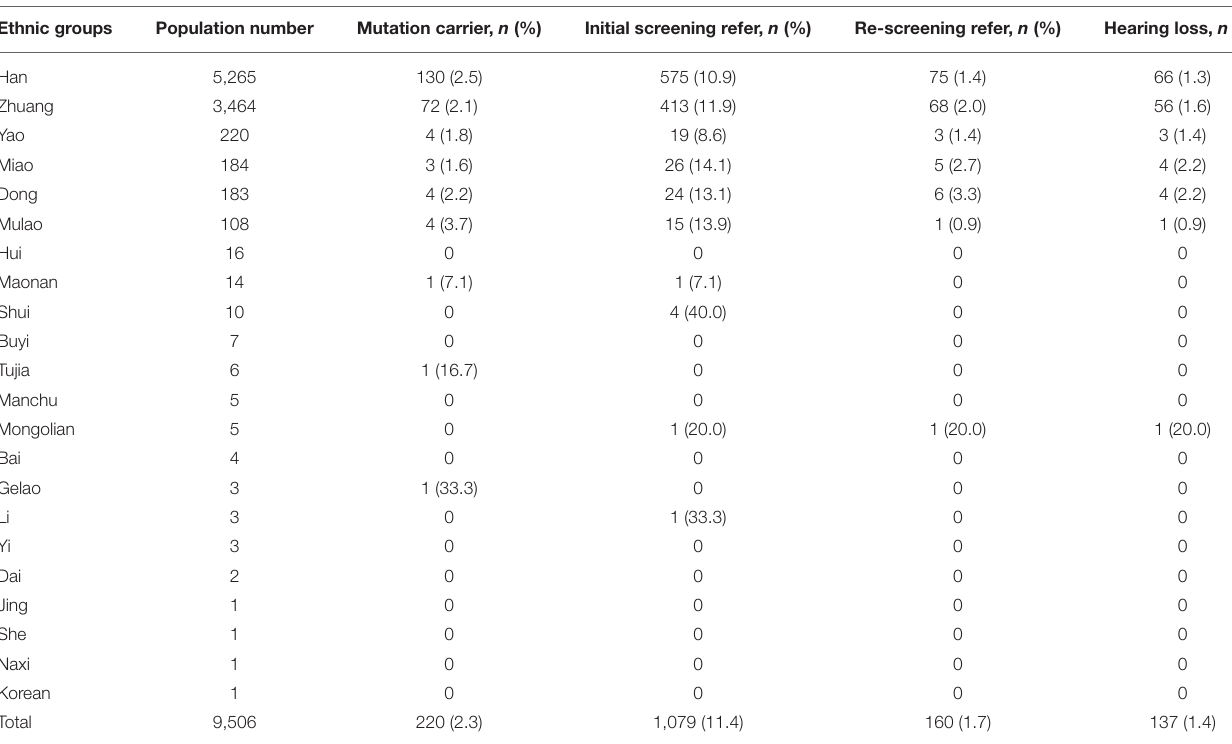
TABLE 2 | Results of screening in 21 different ethnic